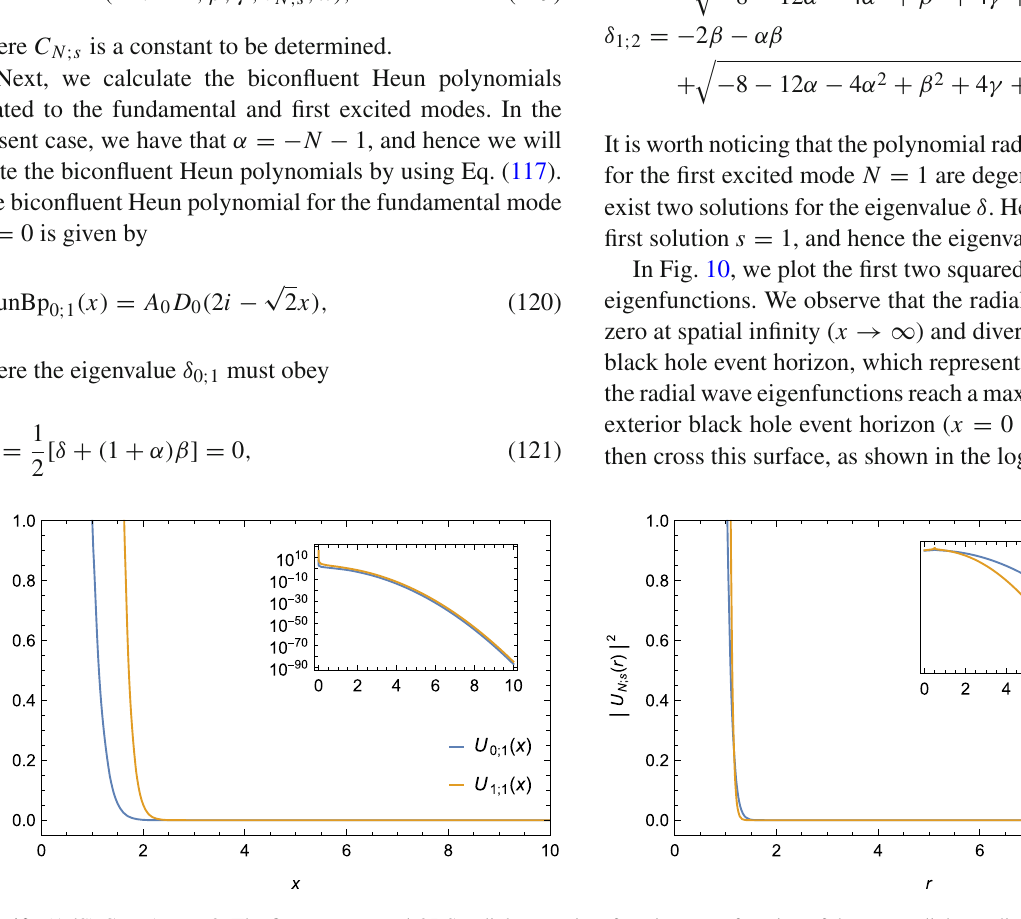
Fig. 10 (AdS) Case 1: a < 0. The first two squared QBS radial wave eigenfunctions as a function of the new radial coordinate x (left) and radial coordinate r (right); a = − 0 . 20, R = 1, M = 0 . 2125. The units are in multiples of C N ;